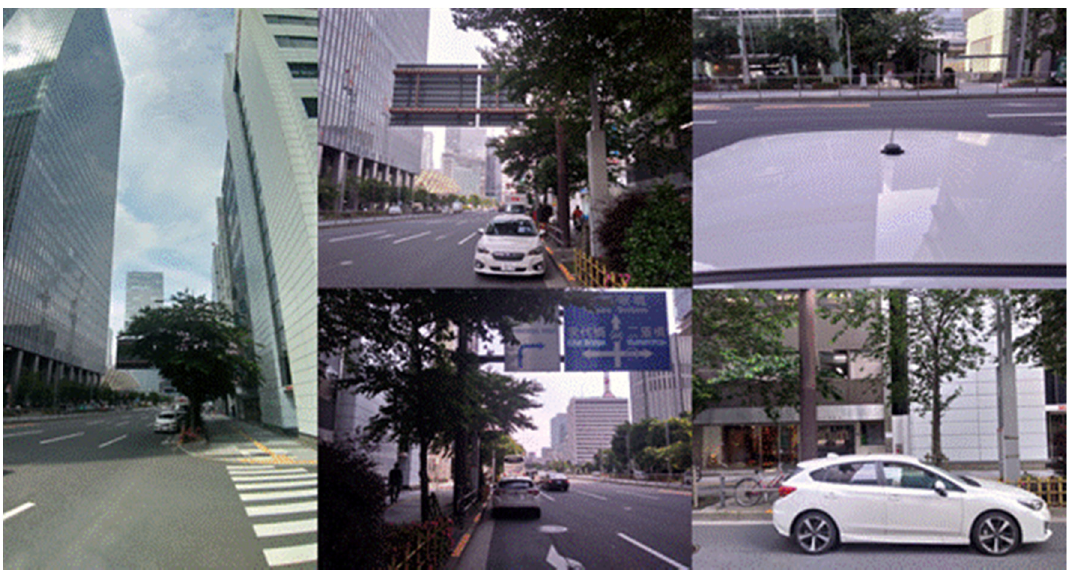
Figure 13 . Detailed images around the antenna. Figure 13. Detailed images around the antenna.